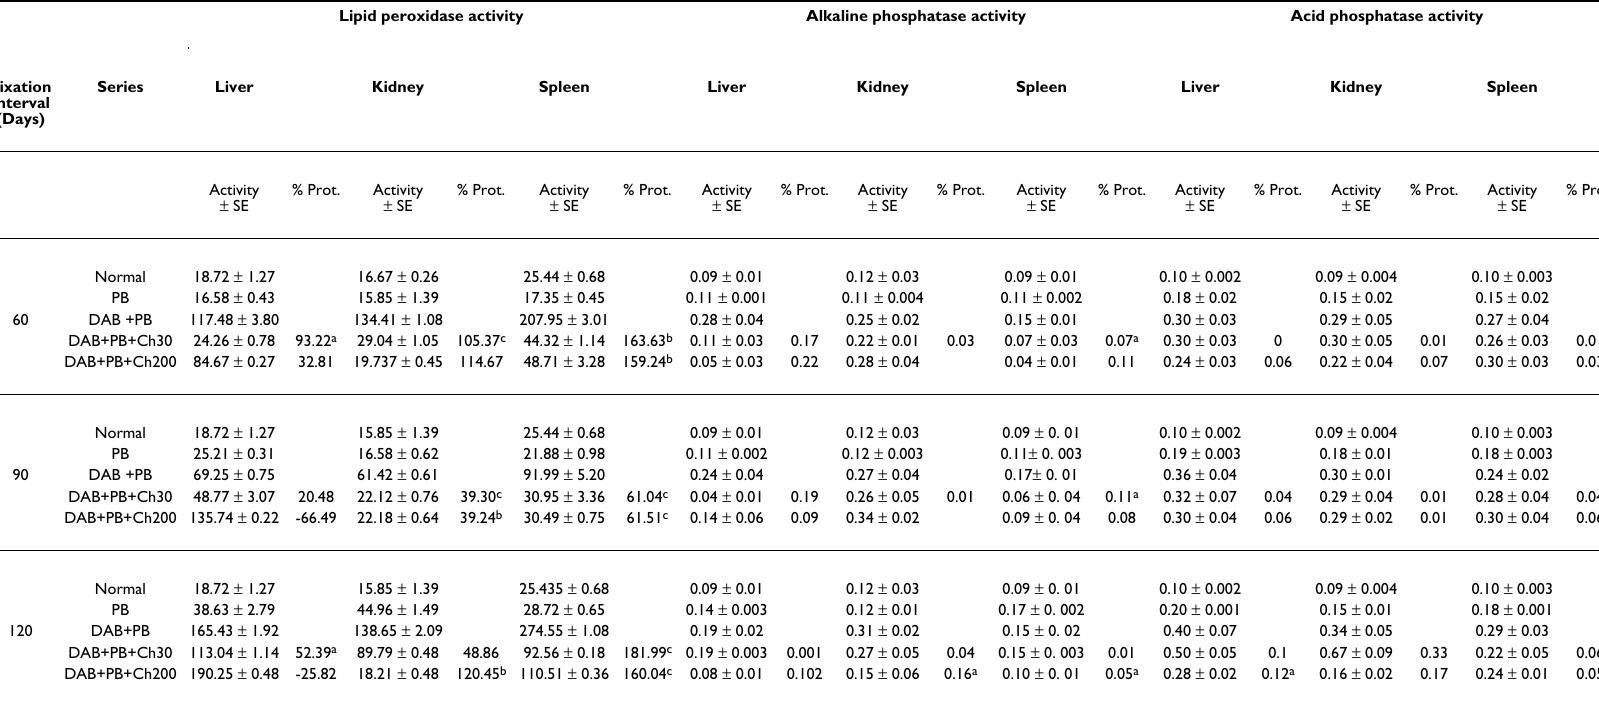
incubation at 37 ° C), in different organs of mice treated with p Dimethylaminoazobenzene (DAB) + Phenobarbital (PB), DAB + PB + Chelidonium (Ch)-30 and DAB + PB + Che- lidonium (Ch)-200 against their normal and phenobarbital